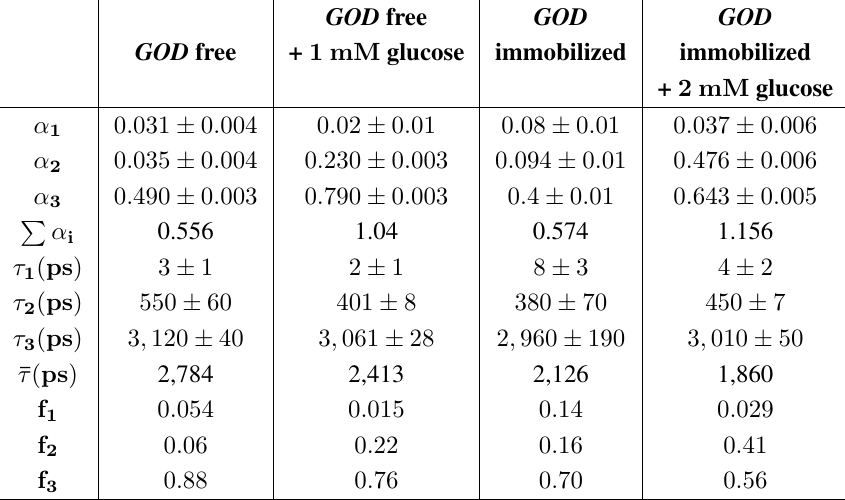
, total fluorescence intensity i of the three-exponential model for free and immobilized GOD i